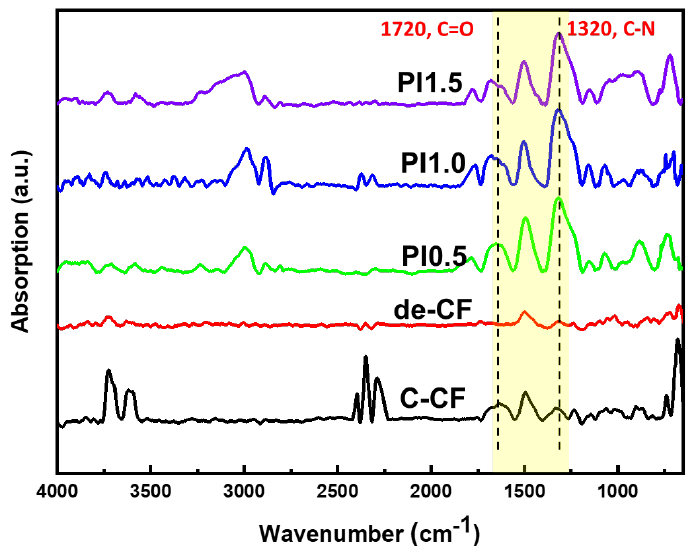
Figure 6. FT-IR spectra of C-CFs and de-CFs as well as 0.5, 1.0, and 1.5 wt% PI-sized Figure 6. FT−IR spectra of C−CFs and de−CFs as well as 0.5, 1.0, and 1.5 wt% PI−sized CFs.